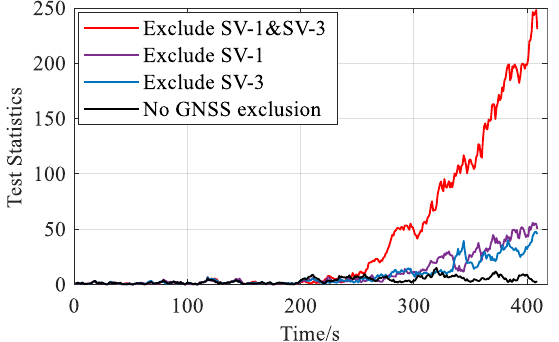
Figure 13. Chi-squared test statistics in filter fault (FF) detector before / after GNSS fault exclusion.